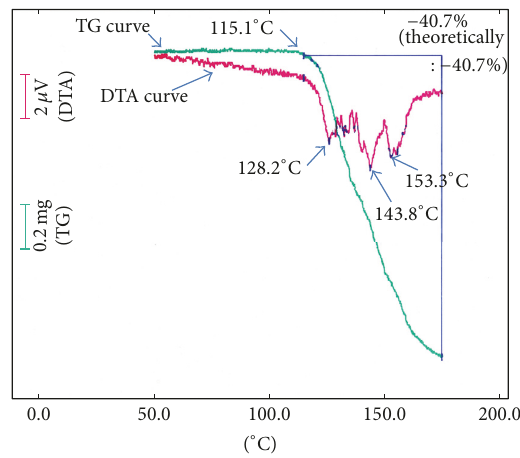
Figure 3: Thermal analysis of Boc-Gly-L-Asp ( 5a ). Heating rate: 4.7 ∘ C/min; carrier gas: He, 50 mL/min; AMP range: DTA: 200 𝜇 V; TG: 10 mg on a Pt cell (2.65 mm × 5.40